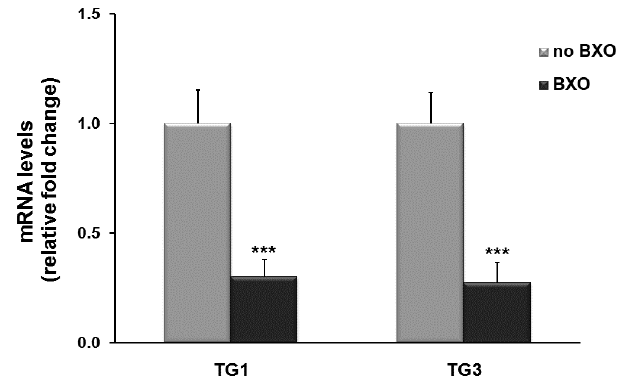
Figure 3. TG1 and TG3 transcript levels in foreskin tissues from patients with and without BXO (no BXO). Results from real-time PCR are expressed as relative fold change compared with foreskin from patients without BXO (no BXO). The data are the means ± standard error of the mean (SEM). *** p < 0.0001 shows significant differences in comparison with patients without BXO.